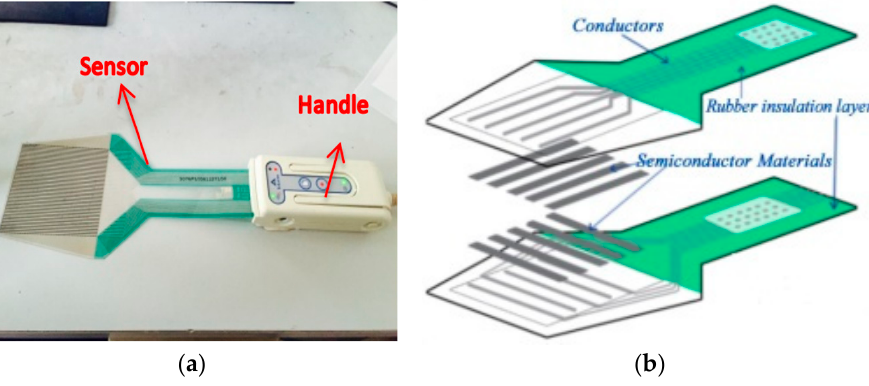
Figure 1. Thin fi lm pressure sensor: ( a ) Tekscan sensor and ( b ) sensor composition. Figure 1. Thin film pressure sensor: ( a ) Tekscan sensor and ( b ) sensor The connection diagram between the conductive handle and the sensor is shown in Figure 1a. The connection part in the handle has a conductive interface that can transmit the electrical signal from the sensor fi lm to the computer.